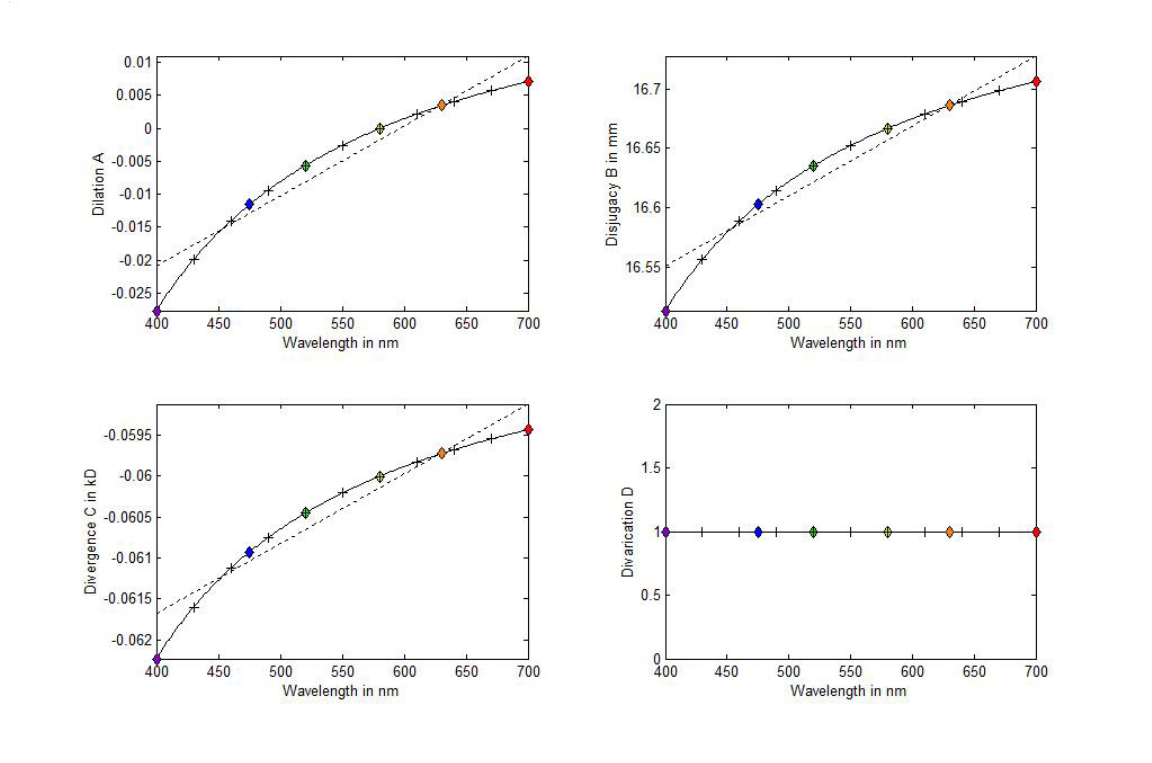
Figure 3. The four fundamental properties of the reduced eye as a function of wavelength. The black crosses represent 10 equal intervals of 30 nm